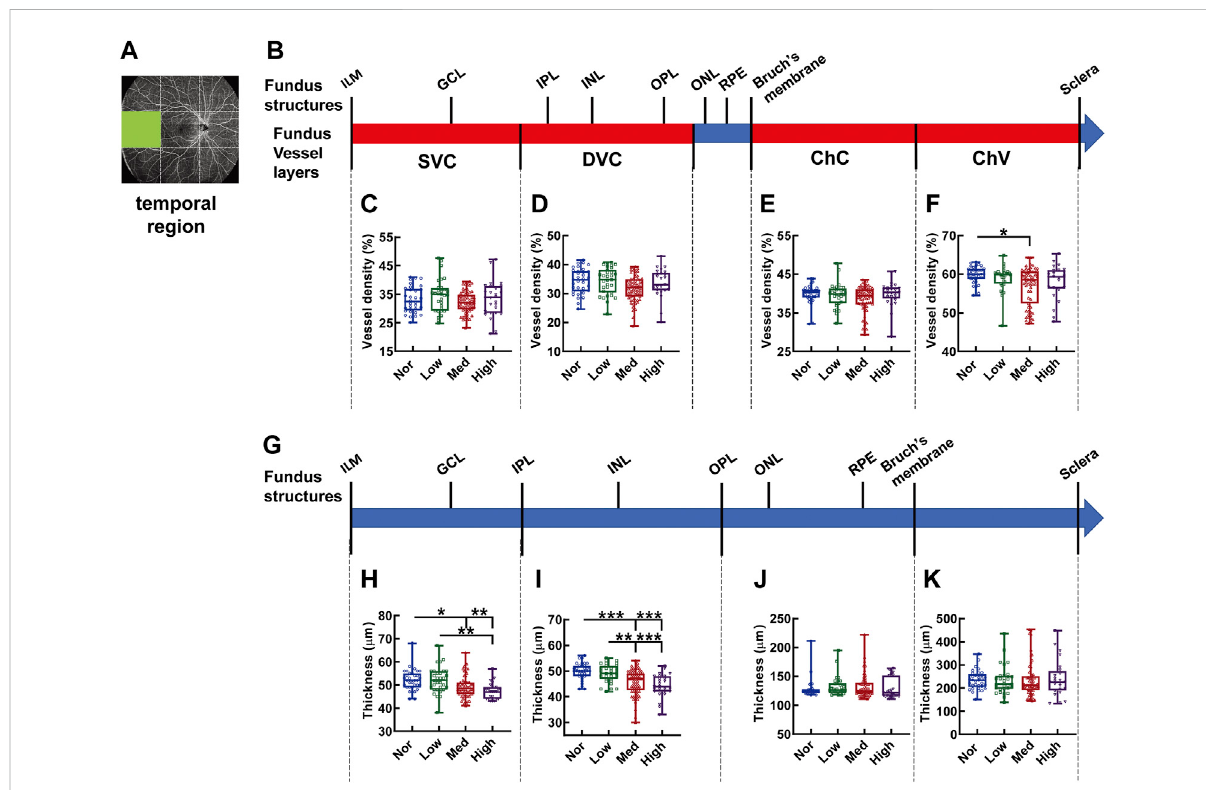
FIGURE 6 Vessel layer densities and structure thicknesses at the temporal region of the fundus. Position of the temporal region of the fundus is illustrated in (A) . Schematic illustration of vessel layers in the fundus is shown in (B) . Vessel densities of super fi cial vascular complex (C) , deep vascular complex (D) , choriocapillary (E) , and choroidal vessel (F) layers are quanti fi ed and compared. Schematic illustration of segments in the fundus is shown in (G) . Thicknesses of the segments from IML to IPL (H) , from IPL to OPL (I) , from OPL to Bruch ’ s membrane (J) , and from Bruch ’ s membrane to the sclera (K) are quanti fi ed and compared. * p < 0.05, ** p < 0.01, *** p < 0.001. SVC, super fi cial vascular complex; DVC, deep vascular complex; ChC, choriocapillary layer; ChV, choroidal vessel layer; NOR, normal group; Low, low-myopia group; Med, medium-myopia group; High, high myopia group; IML, inner limiting membrane; IPL, inner plexiform layer; and OPL, outer plexiform